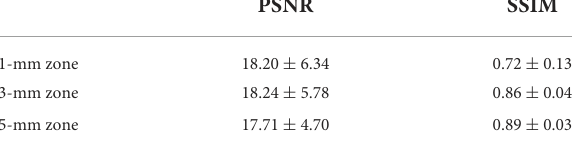
TABLE 4 PSNR and SSIM of different corneal